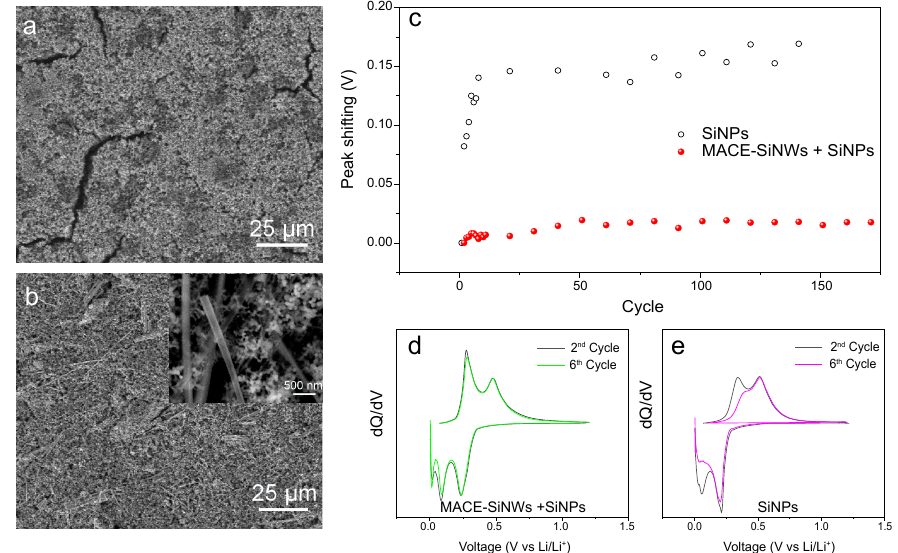
Figure 6. SEM images of a SiNPs-US electrode, ( a ), and the hybrid MACE-SiNWs/SiNPs-US electrode, ( b ). Inset in ( b ) is displayed a closer SEM image of the SiNPs/SiNWs mixture. In ( c ), is represented the voltage shifting of the delithiation peaks of the SiNPs and hybrid electrodes along 150 cycles. The peaks position were obtained from the dQ/dV curves such as those shown in ( d , e